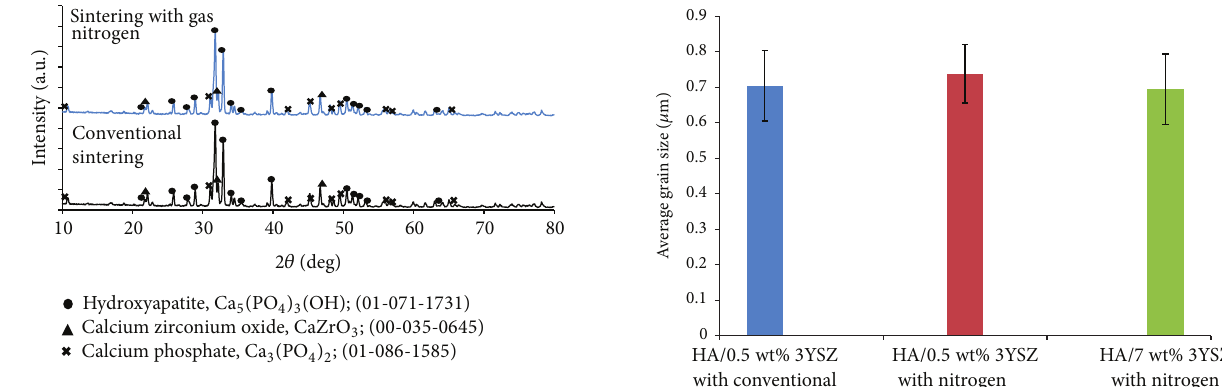
Figure 5: XRD patterns of HA with the addition of 7 wt% 3YSZ under two different sintering atmospheres at 1250 ∘ C.